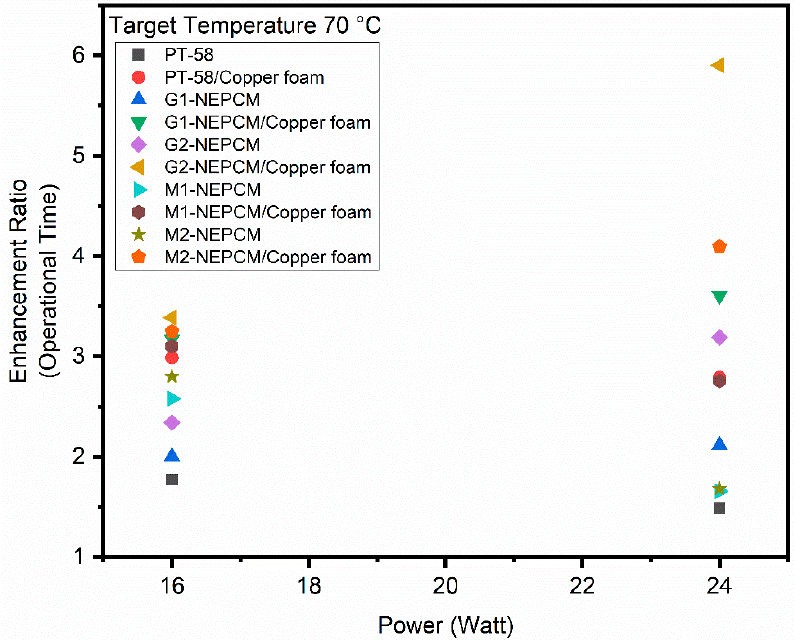
Figure 24. Enhancement ratios comparison for various heat sink configurations at operational time of 70 ℃.